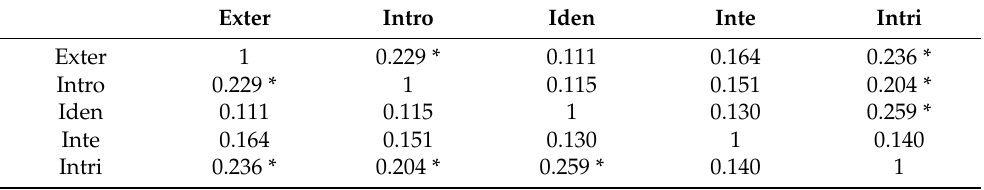
Table A1. Correlations among the five motivational subscales for the group with <5 years of